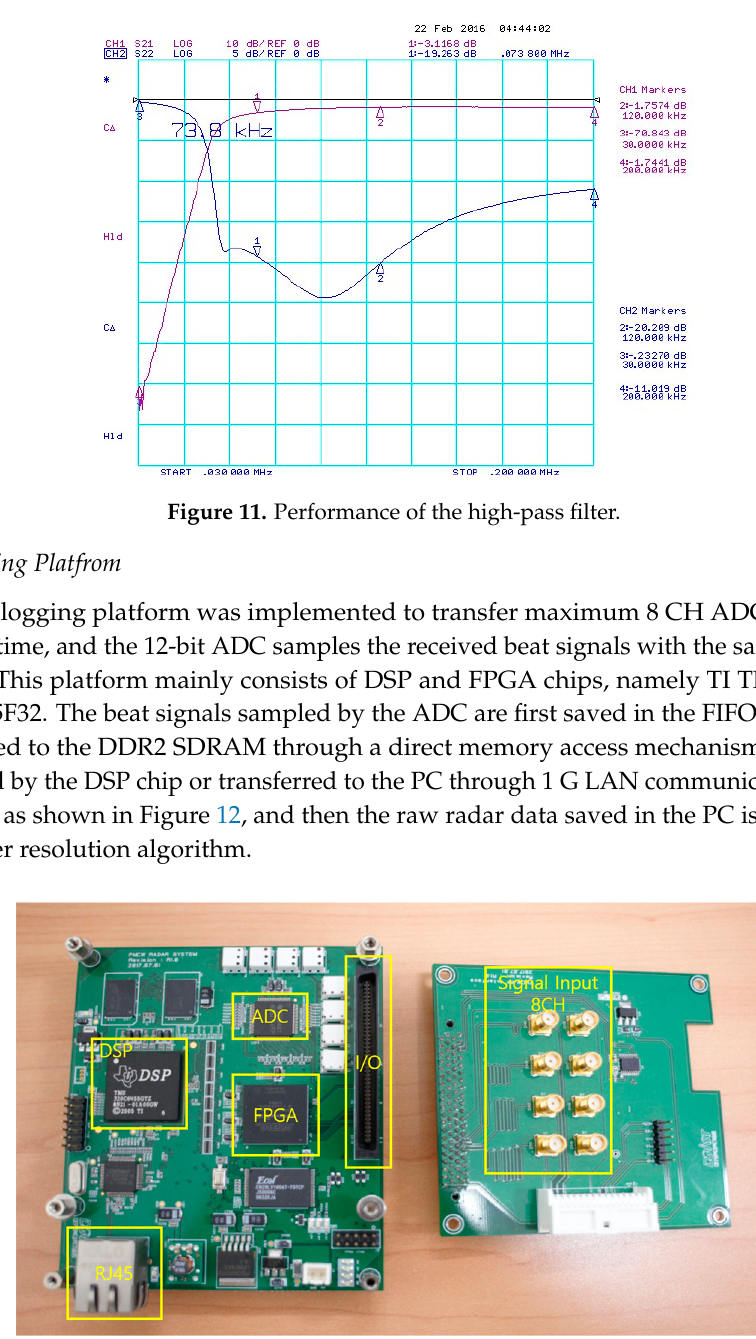
Figure 10. Submodules of IF, ( a ) high-pass filter; ( b ) coaxial cables; ( c ) voltage gain control amplifier (VGA).